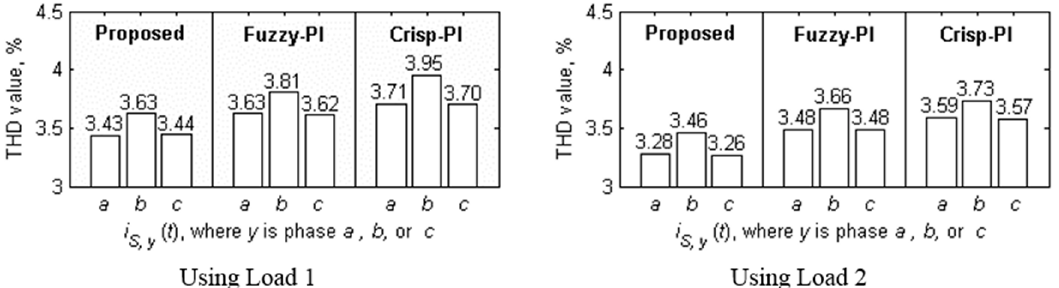
Figure 13. THD values of simulated steady-state 3-phase i S ( t ) using Load 1 and Load 2. The SAPF applies the (a) Proposed, (b) Fuzzy-PI or (c) Crisp-PI CCA.